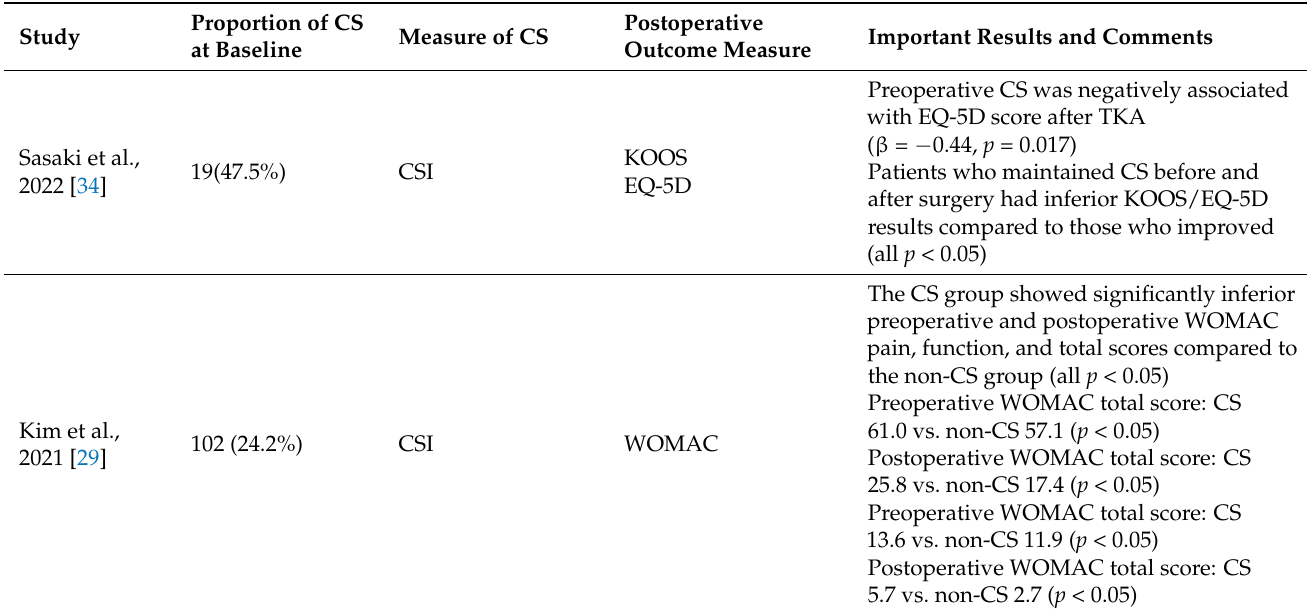
Table 2. The diagnosis of CS and the relationship between CS and postoperative outcomes after